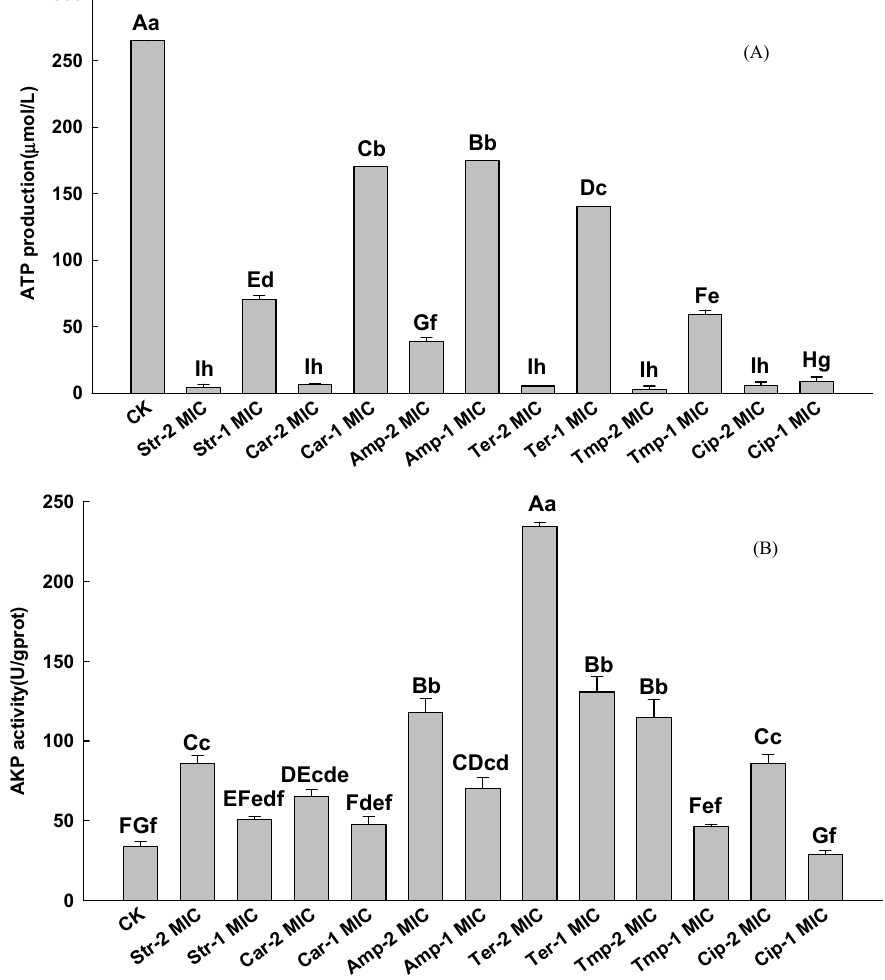
Figure 4. Effects of Str, Car, Amp, Ter, Tmp, and Cip on intracellular ATP production ( A ) and AKP activity ( B ) in PAO1-CE. The values represent the means ± SE (n = 3). Different letters indicate a significant difference between the groups (capital letter, p < 0.05; small letter, p < 0.01).